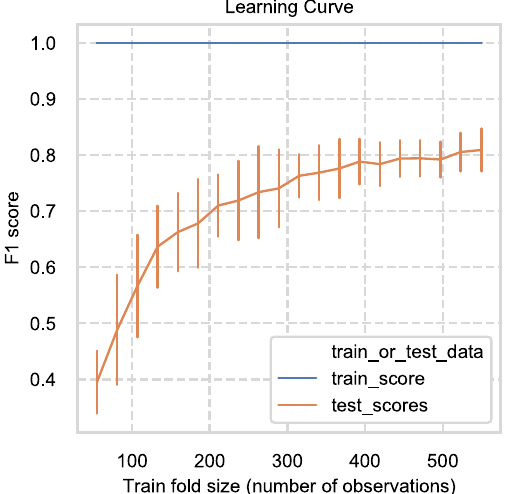
Figure 9. Learning curve shows F1 score for train and test data against number of observations in training